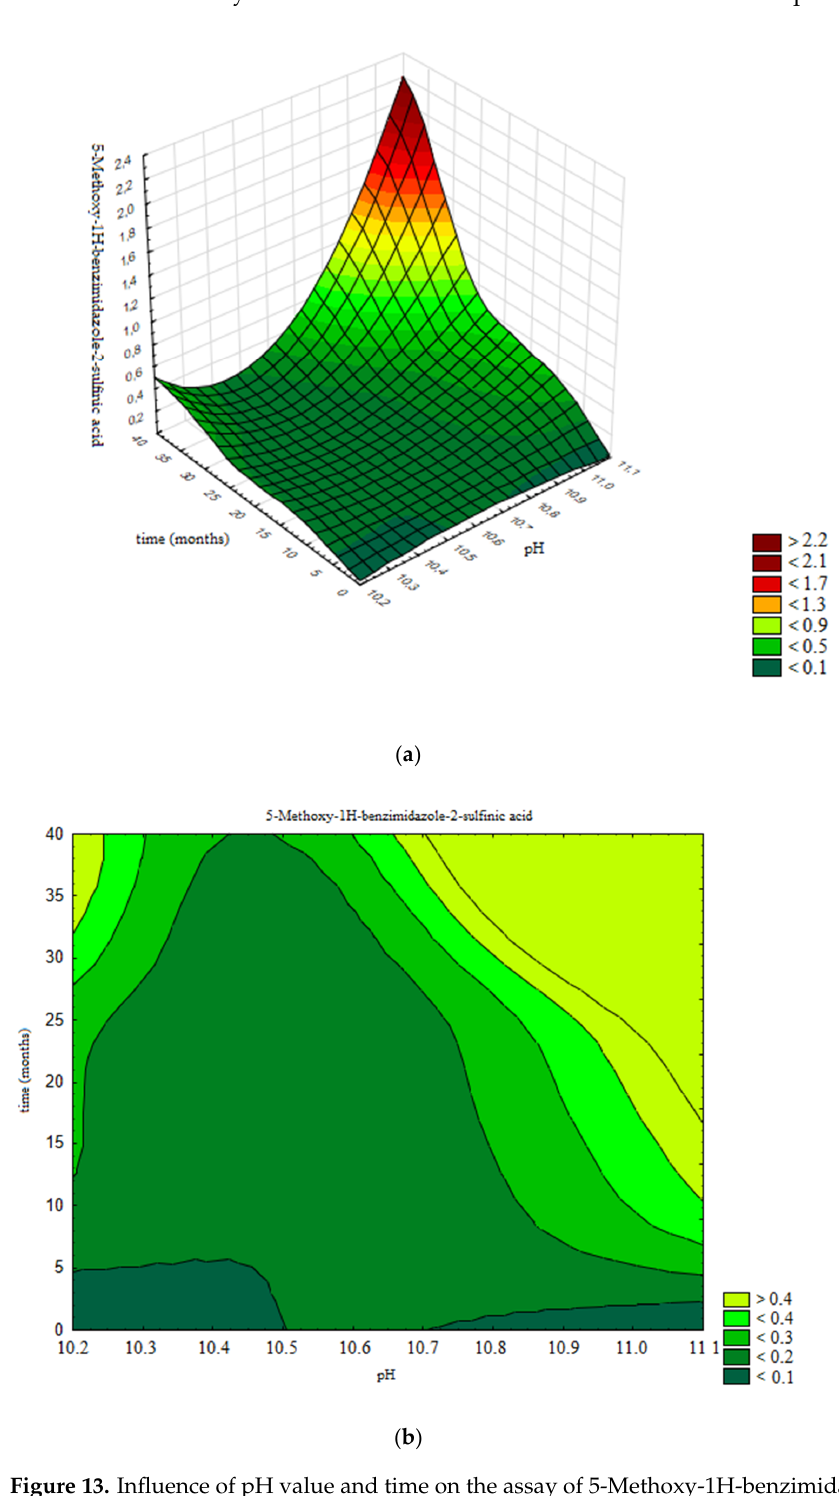
Figure 13. Influence of pH value and time on the assay of 5-Methoxy-1H-benzimidazole-2-sulfinic acid: ( a ) Response surface; ( b ) Contour plot.